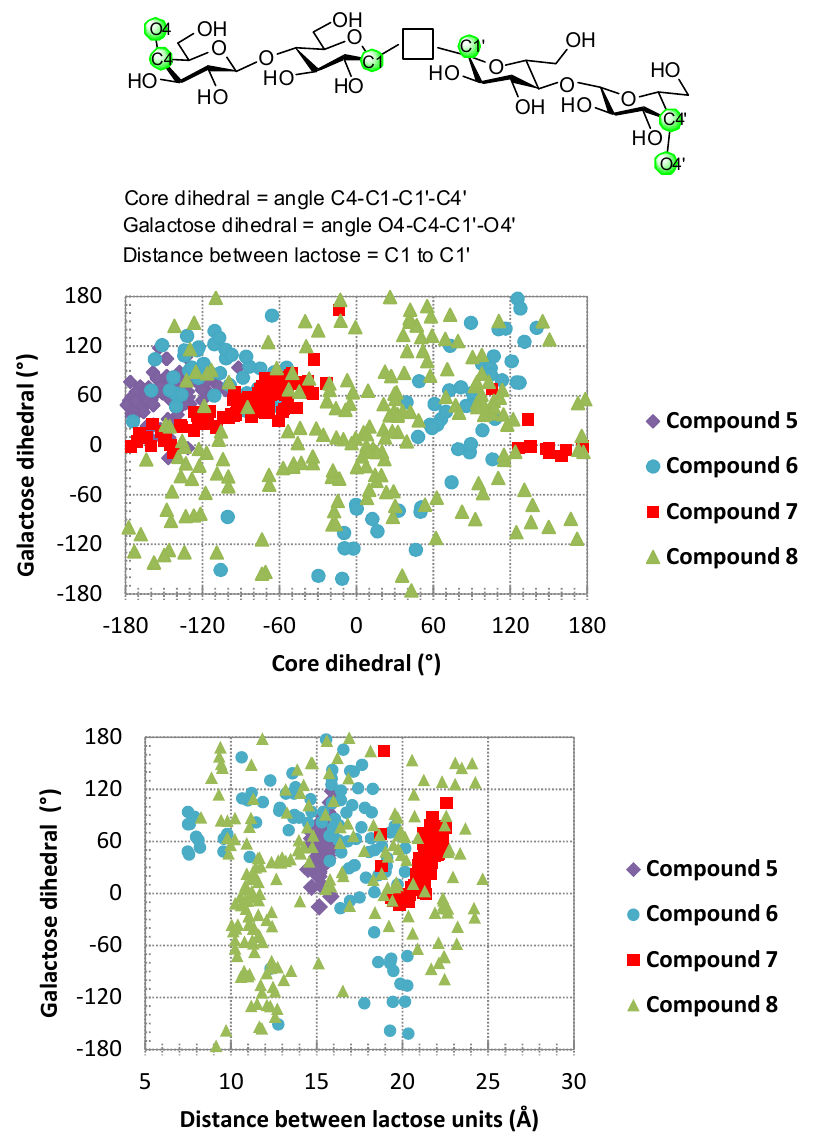
Figure 9. Spatial parameters for extended conformers of compounds 5 – 8 . The definition for the galactose dihedral, core structure and distance between lactose units is shown on